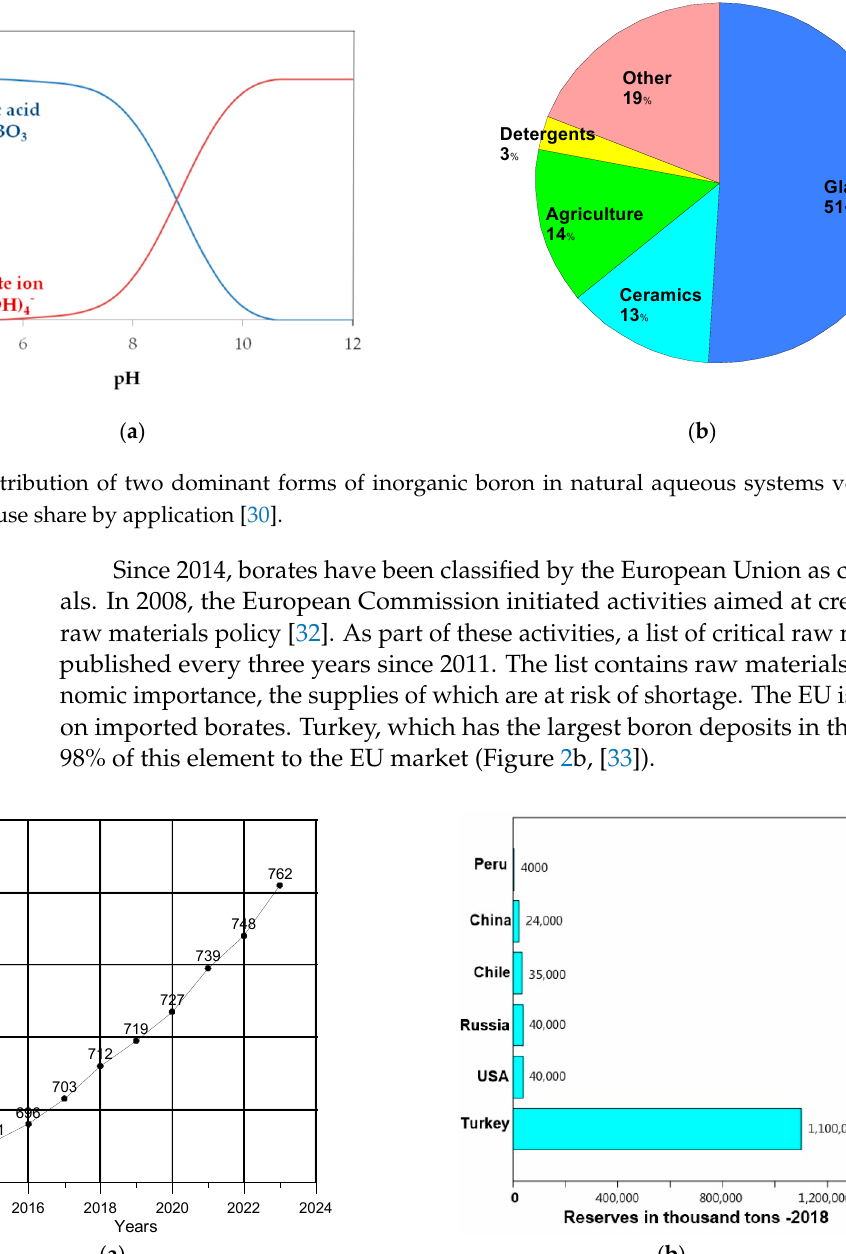
Figure 1. ( a ) The distribution of two dominant forms of inorganic boron in natural aqueous systems versus pH [26], ( b ) global boron end-use share by application [30].